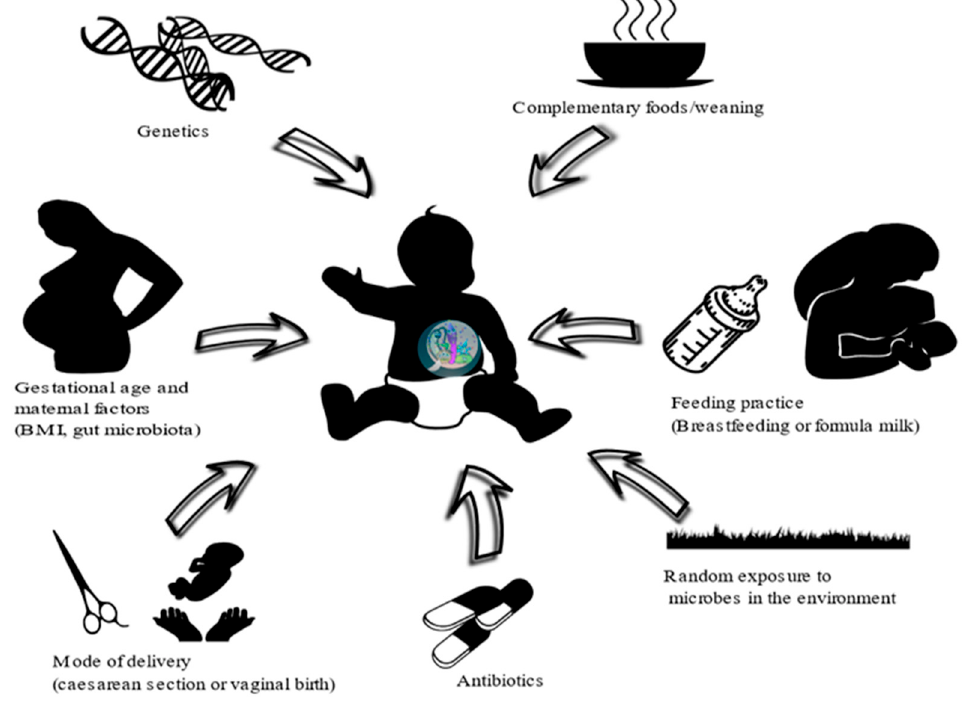
Figure 1. Major factors affecting the microbial composition of the gut in infants.